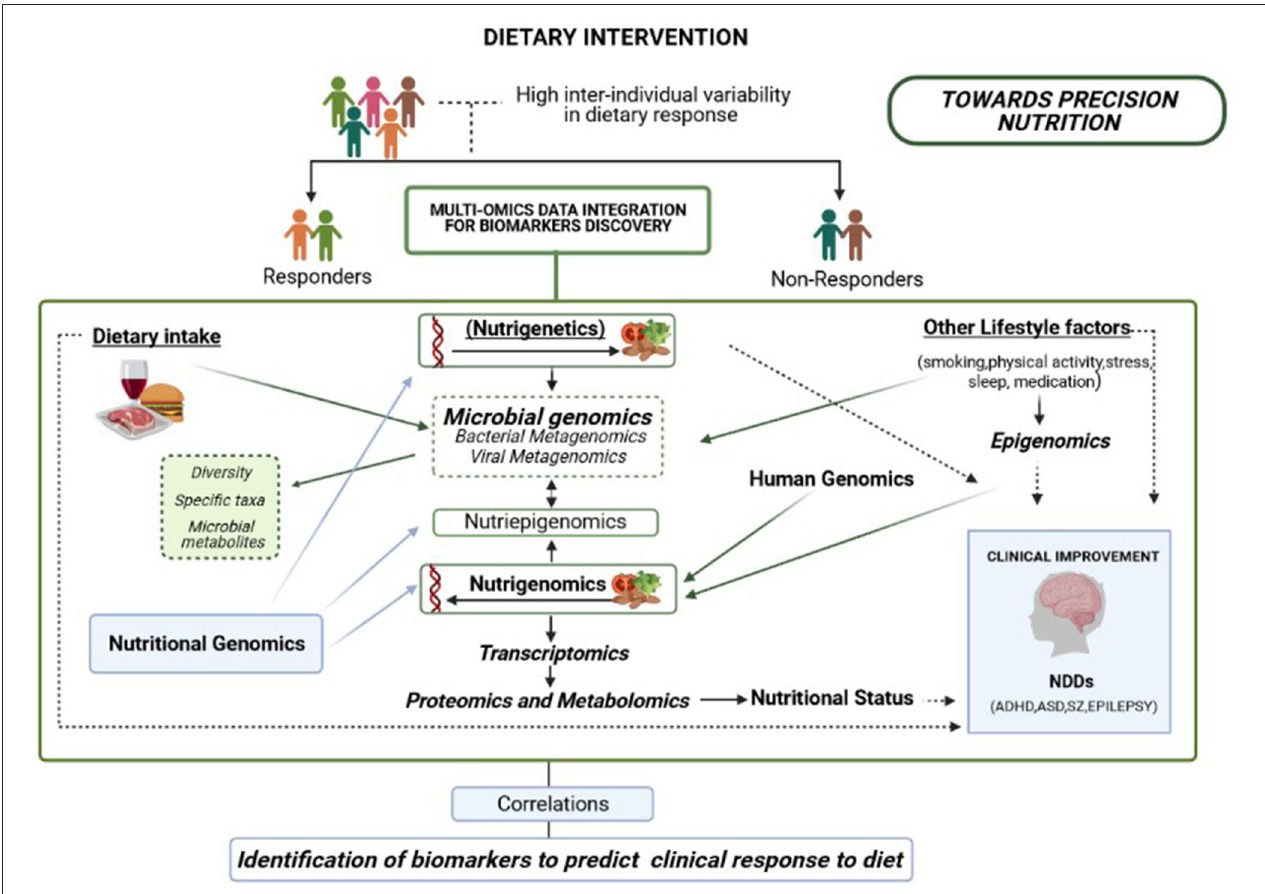
FIGURE 3 | Overview of a multi-omics integration analysis to reveal biomarkers able to predict clinical response to diet, including genomics, metagenomics, epigenomics, transcriptomics, proteomics, and metabolomics. An integrated approach is necessary to improve the effectiveness of dietary interventions aiming to promote healthy brain development according to multiple individual features, including baseline microbiome signatures.